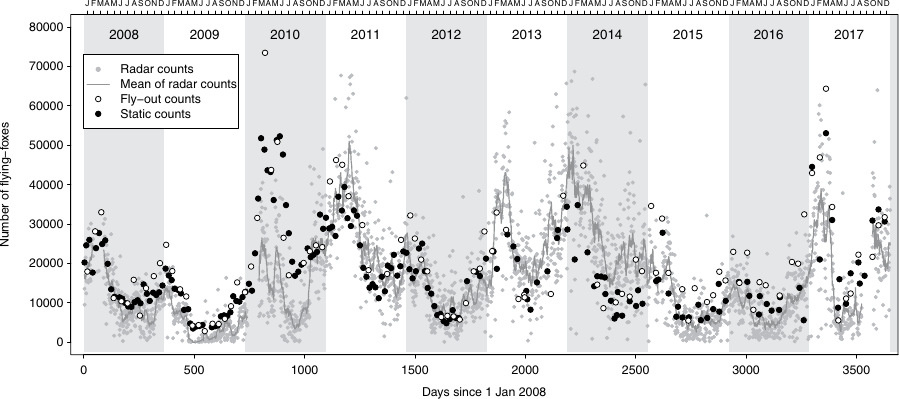
Figure 1. Radar-based and ground-based estimates of the numbers of flying-foxes at the Yarra Bend roost between 2008 and 2017. Radar-based counts are represented as grey dots (n = 3013) and have a 14-day running mean fitted (grey line). Ground-based estimates from human observers are divided into fly-out (white dots, n = 90) and static (black dots = 156) counts 1,24